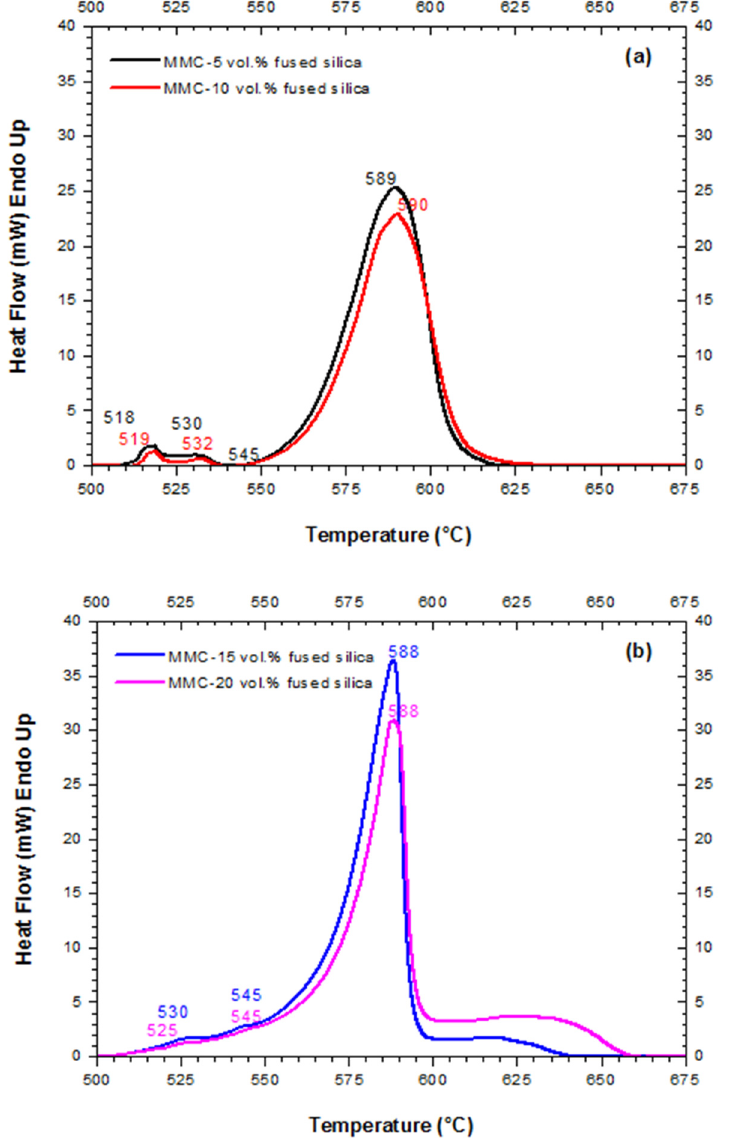
Figure 2. DSC curves of the green bodies of ( a ) MMC-5 and 10 vol.% of fused silica and ( b ) MMC-15 and 20 vol.% of fused silica.